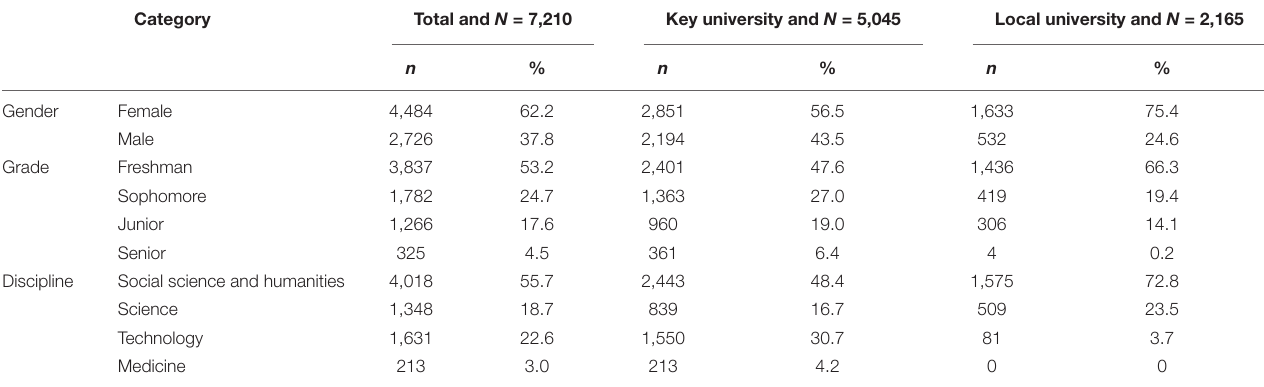
TABLE 1 | The demographic characteristics of the sample ( N = 7,210).